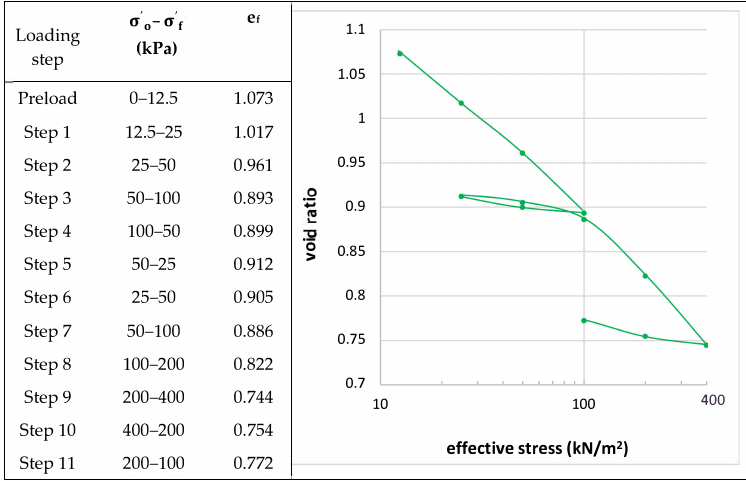
Figure 4. Compressibility curve of the